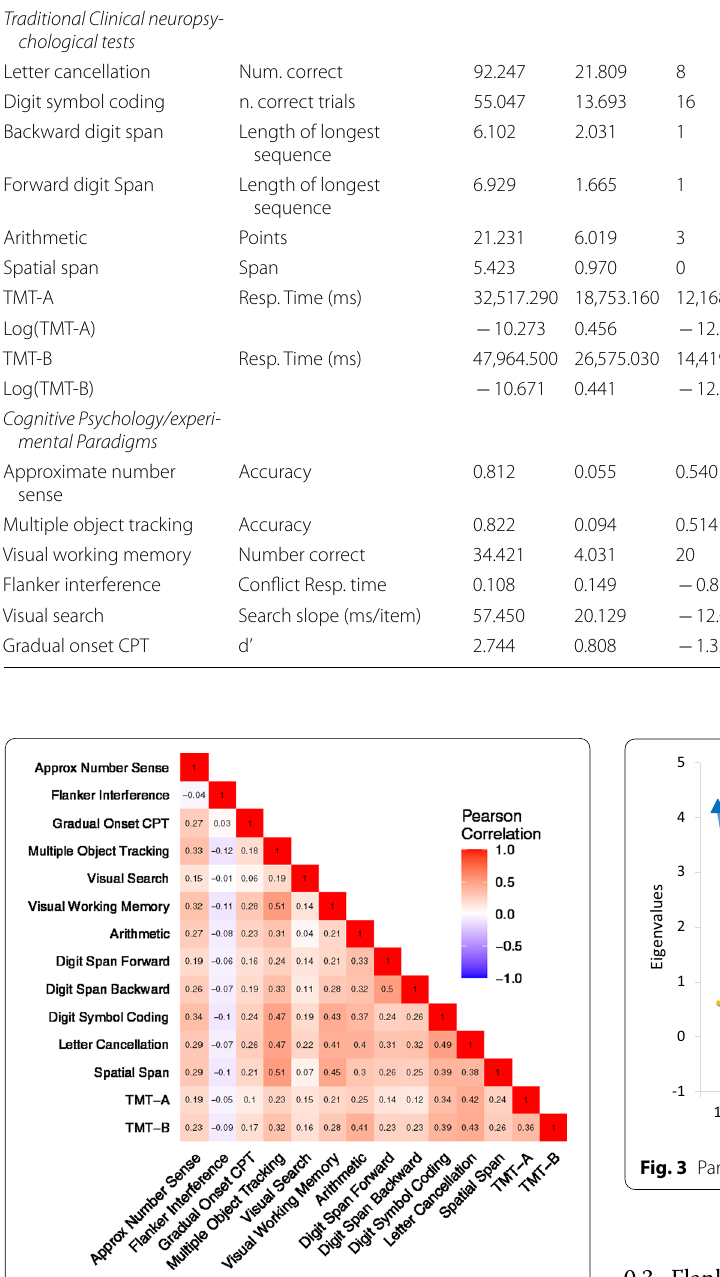
Fig. 2 Correlation matrix. Note that TMT-A and TMT-B are log-transformed, and the sign of correlation coefficients was flipped for TMT-A, TMT-B, and Visual Search